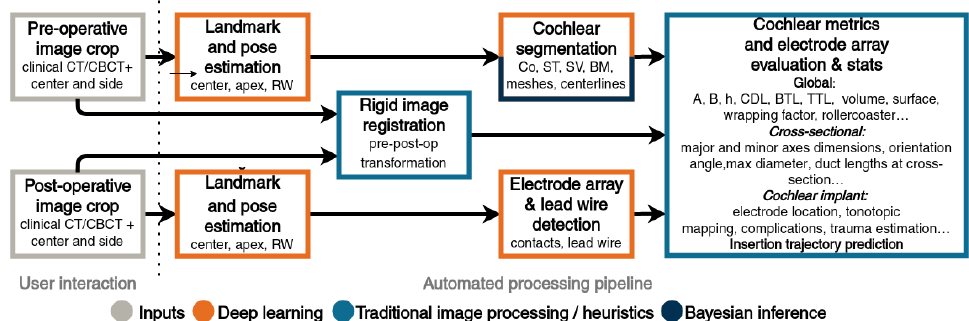
Figure 2. Nautilus pipeline overview. After the images are dropped onto a web browser window, the user moves a cross-hair roughly to the cochlea’s center and selects the side (left/right) and whether it is a pre- or a post-operative scan. A crop (10 × 10 × 10 mm) centered on that landmark is then rid of personally identifiable information and uploaded for processing. First, relevant landmarks (the center, round window, and apex) are estimated and used for initial cochlear pose (reference coordinate system) computation. Segmentation of the cochlear bony labyrinth (CO) is obtained through a convolutional neural network, whereas subsequently, the scala tympani (ST) and scala vestibuli (SV) are obtained using Bayesian inference. From the post-operative image, electrode array contact coordinates and lead wire are extracted and fit to the Oticon Medical EVO electrode CAD model. An interactive visualization as well as pre- and post-operative metrics are available directly on the web browser. A number of additional outputs are generated by the pipeline and made available for data export for further processing and applications. The segmentations can be exported in STL format for 3D printing, for instance. An estimate of electrode trajectory is also provided from the pre-operative image to estimate the equivalent angular coverage for a given electrode insertion depth in